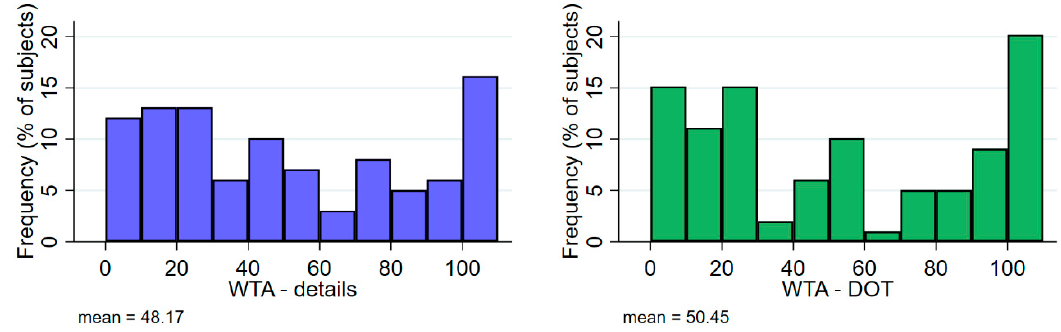
Figure 2. Distribution of willingness to accept (WTA) bids across personal details and DOT decisions.